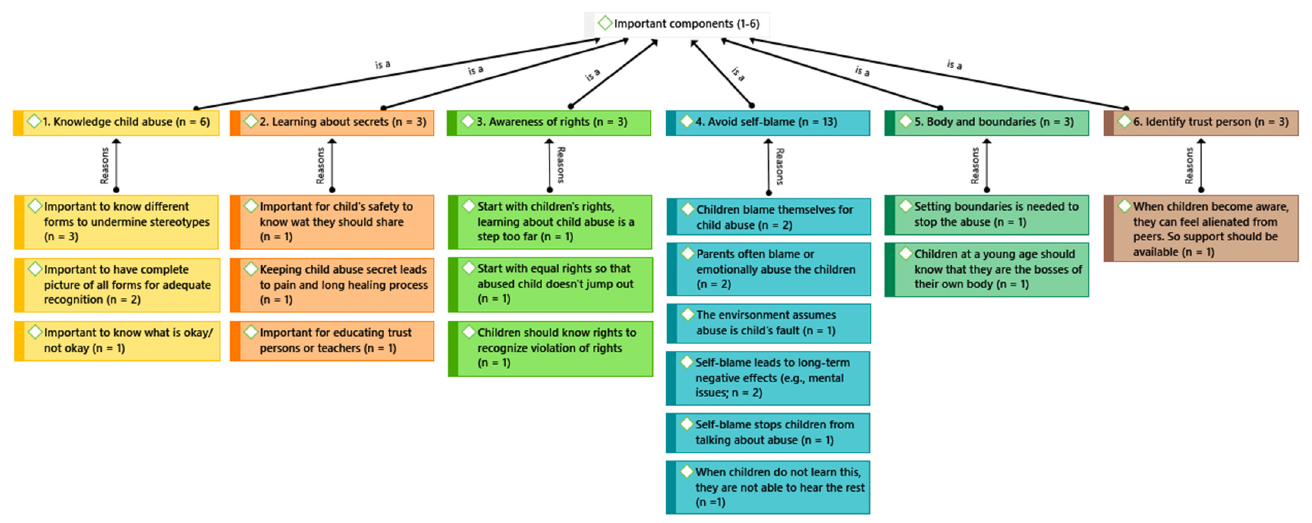
Figure 1. An overview of the results as related to the first set of six components. The labels on the second level refer to the components and the labels on the third level refer to the reasons as provided by the participants for the importance of each component. Yellow labels refer to the components (1) promoting knowledge on child abuse, orange labels to (2) learning about secrets, light green labels to (3) increasing awareness of children’s rights, turquoise labels to (4) learning to avoid self-blame, dark green labels to (5) learning about own body and boundaries, and brown labels to (6) identifying trusted persons. n = the number of participants. Table 1. An overview of the key themes and corresponding subthemes ( N =